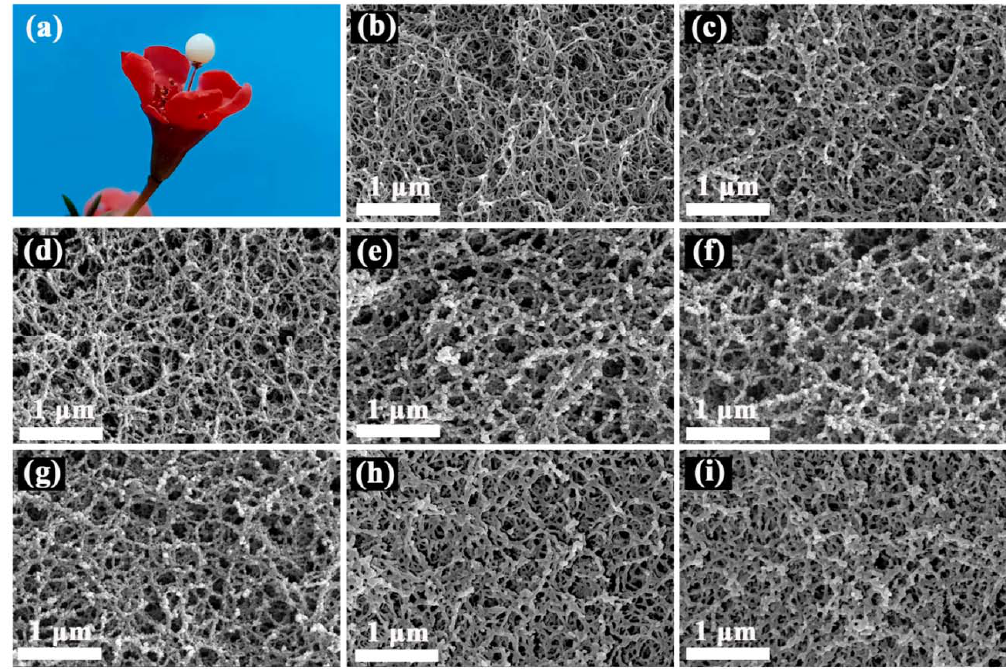
Figure 3. ( a ) Camera photo of the SCAB on flowers. SEM images of ( b ) AABs, ( c ) SCAB ‐ 1, ( d ) SCAB ‐ 2, ( e ) SCAB ‐ 3, ( f ) SCAB ‐ 4, ( g ) SCAB ‐ 5, ( h ) SCAB ‐ 6, and ( i ) SCAB ‐ 7. ( e ) SCAB-3, ( f ) SCAB-4, ( g ) SCAB-5, ( h ) SCAB-6, and ( i )